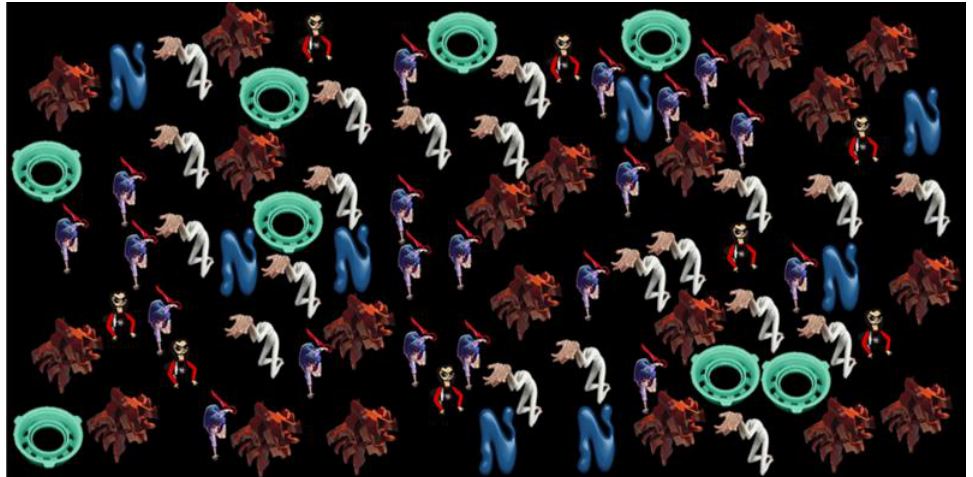
Figure 18. Solution found by the ILS algorithm when inserting 84 pieces for the A1 instance, consuming 4 h of processing time.